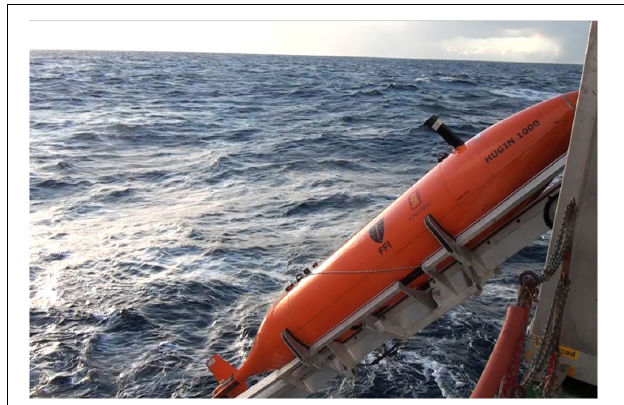
FIGURE 2 | Launch of the HUGIN HUS AUV from the aft of the ship.